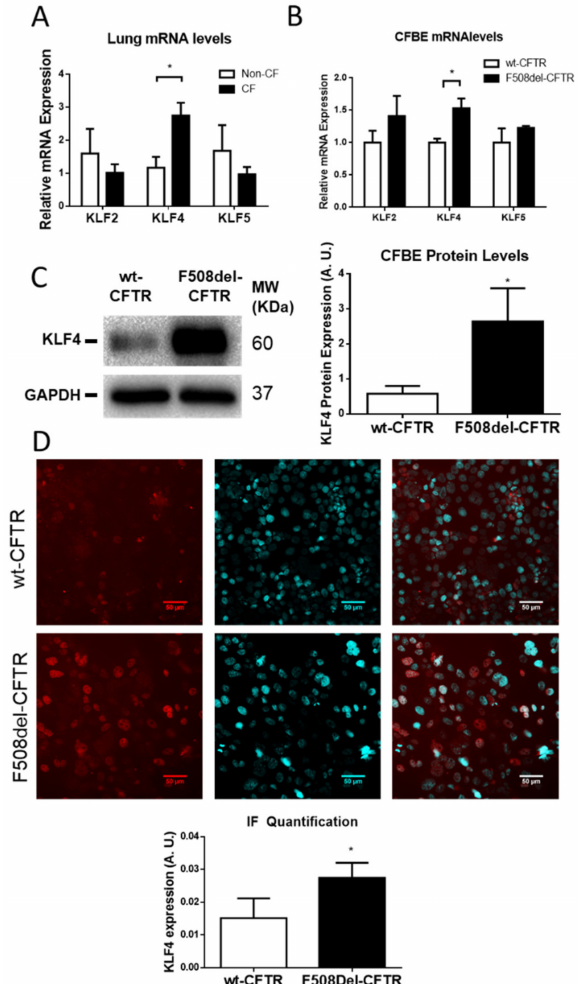
Figure 1. Krüppel-like factor 4 (KLF4) is upregulated in Cystic Fibrosis (CF) native human lung and cell lines. ( A ) KLF2, KLF4, and KLF5 mRNA levels were assessed by RT-qPCR in samples retrieved from lung explant specimens from individuals with CF heterozygous for F508del– CF transmembrane conductance regulator (CFTR) or non-CF controls (n = 4, unpaired t -test, p -value = 0.02). ( B ) KLF2, KLF4, and KLF5 mRNA levels in CFBE cells expressing wt- or F508del–CFTR assessed by RT-qPCR (n = 3, unpaired t -test, p < 0.05). ( C ) Representative WB (left) of KLF4 expression in wt- and F508del–CFTR CFBE cells, using Glyceraldehyde 3-Phosphate Dehydrogenase (GAPDH) as loading control and (right) quantification of data in ( A ) in arbitrary units (A.U.) shown as relative expression vs. loading control (n = 3, unpaired t -test, p < 0.05). ( D ) Representative immunofluorescence staining (IF) images showing KLF4 staining (red, left panels) in wt- and F508del–CFTR expressing CFBE cells, nuclei staining (blue, middle panels) merged images (right panel). Quantification of data below (n = 4, unpaired t -test, p <